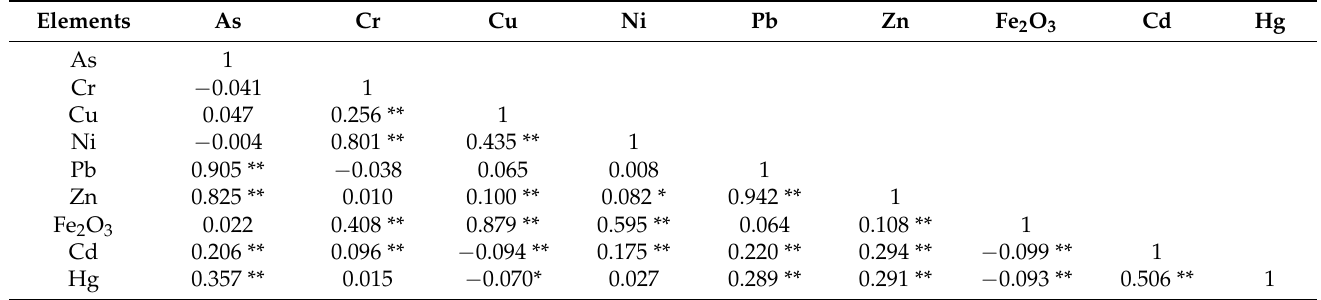
Table 3. Pearson correlations matrix for heavy metal concentrations in topsoil.